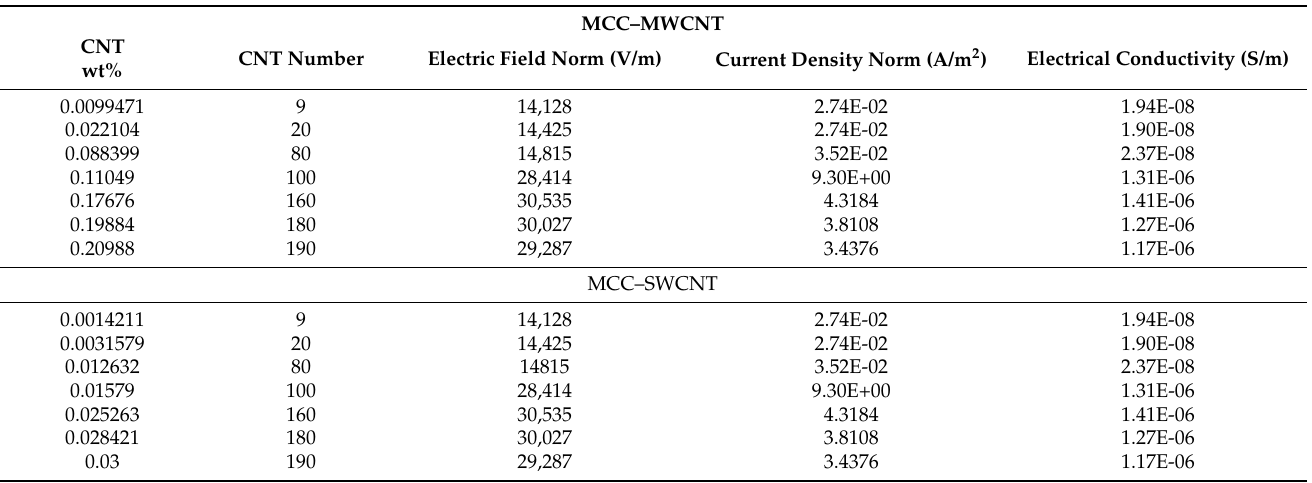
Table 2. The changes in electric field norm (V/m), current density norm (A/m 2 ), and electrical conductivity (S/m) in MCC–CNT with different rolled graphene